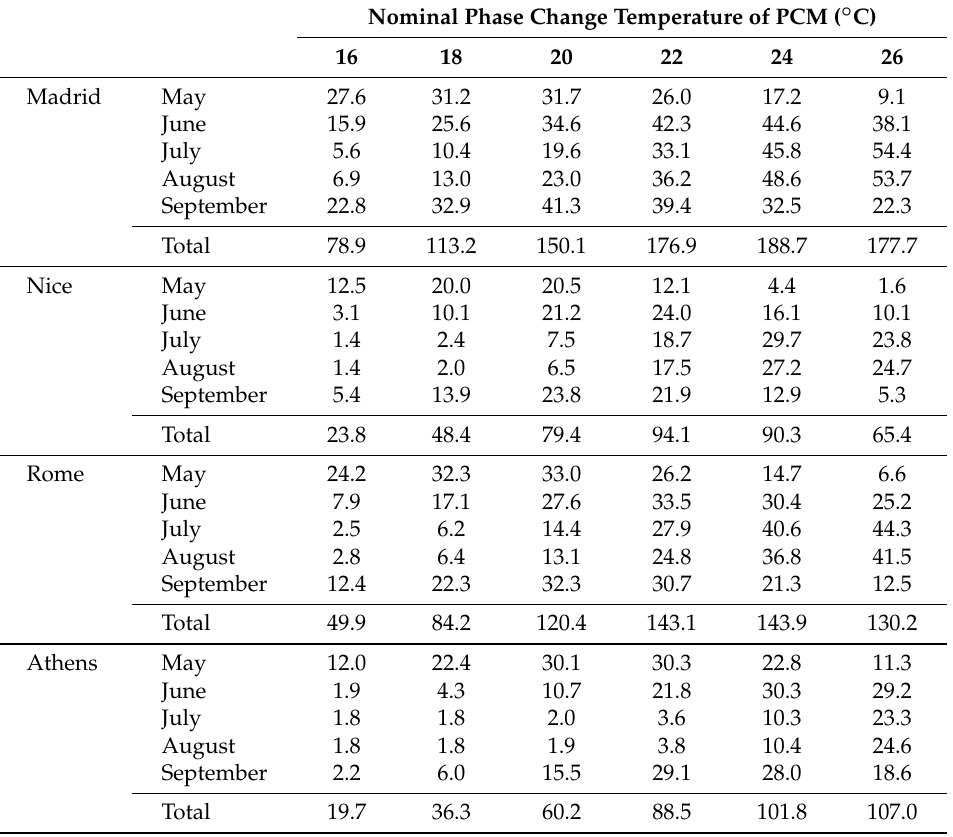
Table 5. Energy saving potential in kWh (cities below 45 ◦ N).